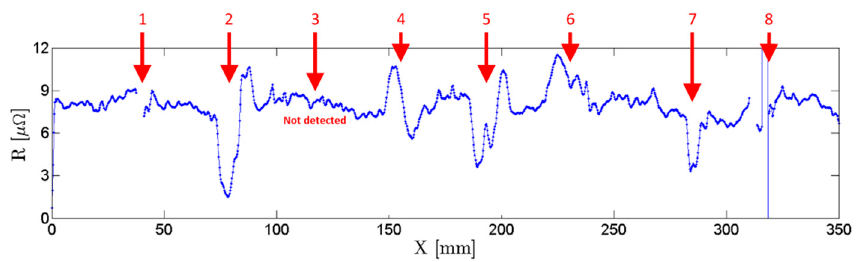
Figure 15. Developed orthogonal-shape four-point probe output signal. Defects 1 to 8 as presented in Table 1.